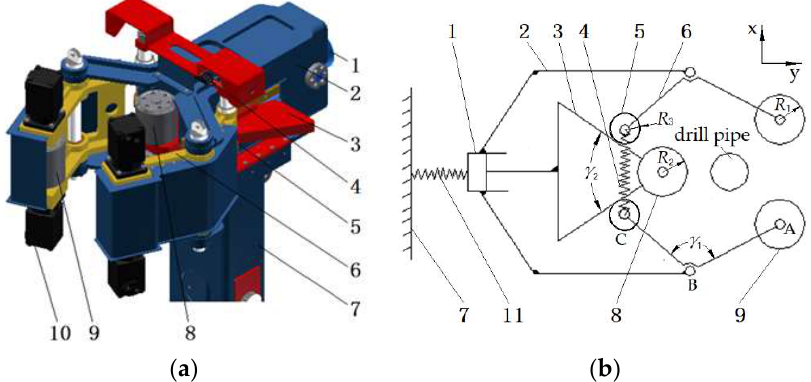
Figure 1. Spinner mechanism: ( a ) three-dimensional model; ( b ) kinematic diagram. In the figure: 1—clamping oil cylinder; 2—cross beam; 3—wedge plate; 4—return spring; 5—tangent wheel; 6—clamping arm; 7—column; 8—follow-up roller; 9—driving roller; 10—hydraulic motor; 11—floating mechanism.